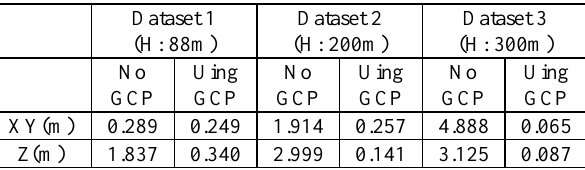
Table 5. RMSE of estimated coordinates on CP